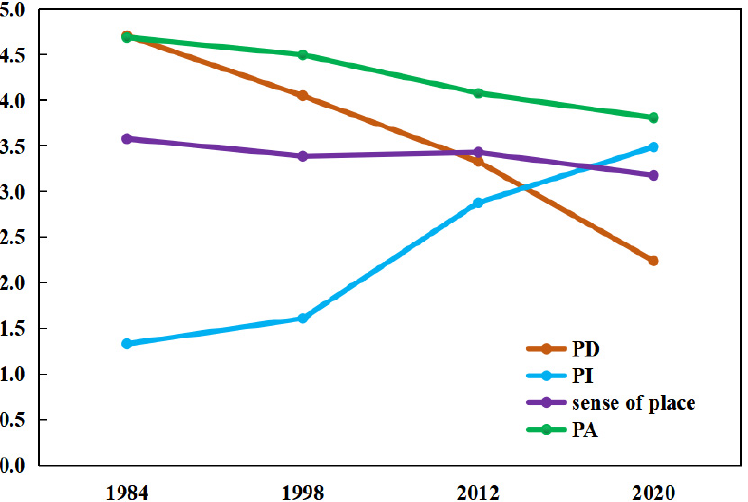
Figure 5. Intensity index of the sense of place of local farmers. PI = Place identity; PD = Place dependence; PA = Place attachment.